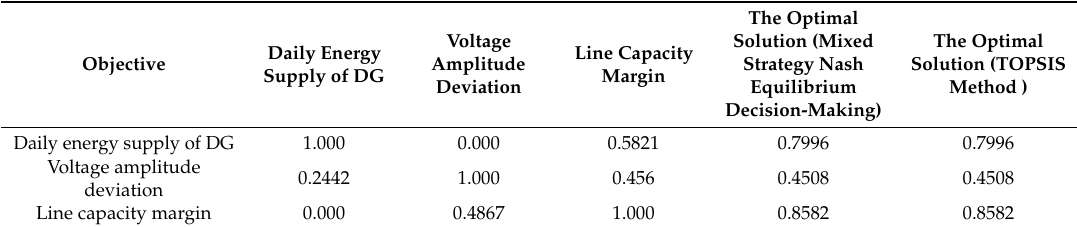
Table 2. The optimal boundary solutions and compromise solutions of the multi-objective optimization